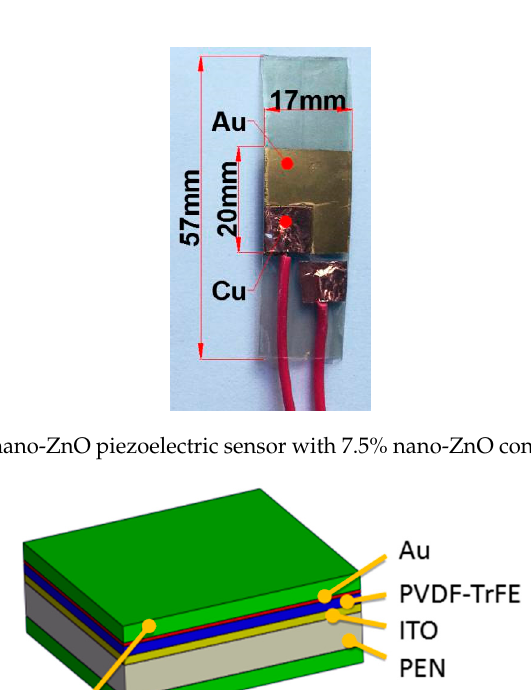
Figure 4. Cross-sectional structure diagram of PVDF-TrFE/nano-ZnO film sensor.